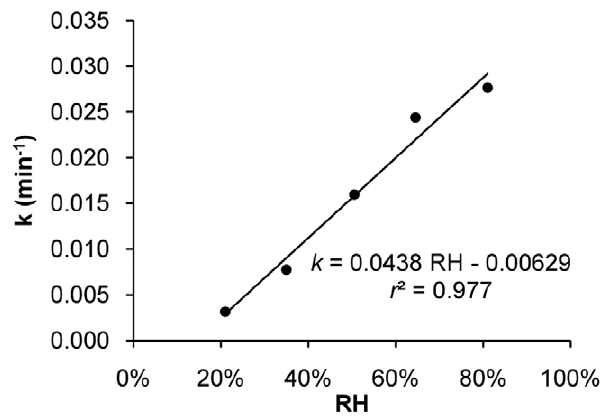
Figure 2. IAV inactivation rate versus RH. IAV inactivation rates ( k ) for each RH over 1 h were calculated based on experimental data adapted from Harper [12].